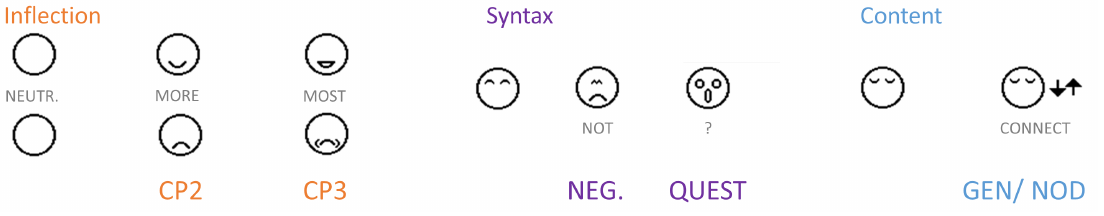
Figure 3. Symbolic description of the NMEs of JSL investigated in this work. Left: NMEs for CP2 and CP3 indicating adjective inflection. Middle: syntactic NMEs to express negations or questions. Right: NMEs carrying contextual information.